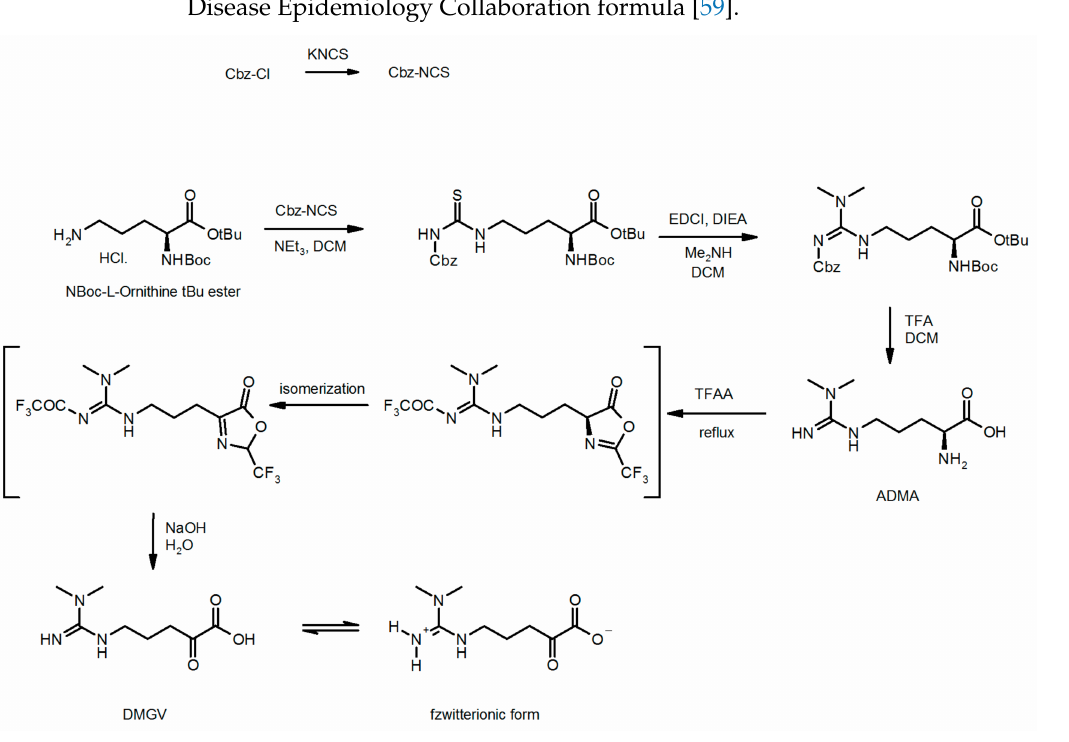
Figure 6. Chemical synthesis of dimethylguanidino valerate